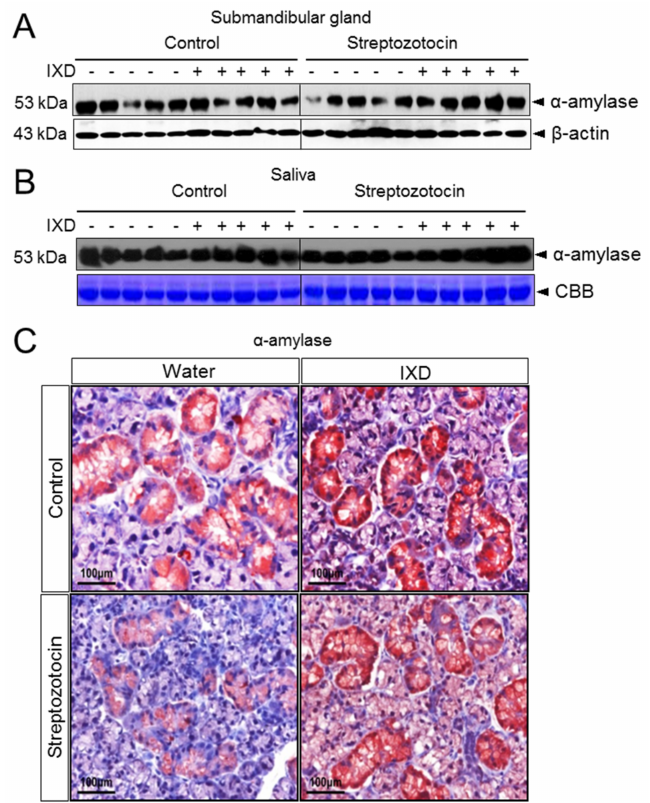
Figure 4. Expression of α -amylase in the submandibular gland and saliva. ( A ) Amylase expression in submandibular gland tissue lysates; ( B ) amylase expression in saliva; ( C ) paraffin-embedded submandibular gland tissues were sectioned at 5 µ m thickness, and immunostaining was performed using an amylase antibody. Brownish red colours indicate immunolocalization of α -amylase in submandibular gland cells. Magnification: 40 × ; Scale bar: 100 µ